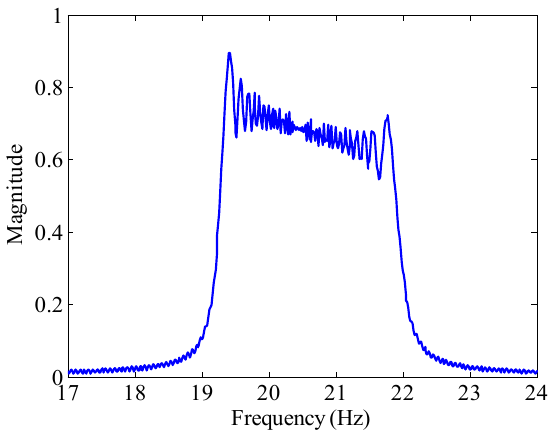
Figure 4. The Fourier spectrum of x ( t ) .